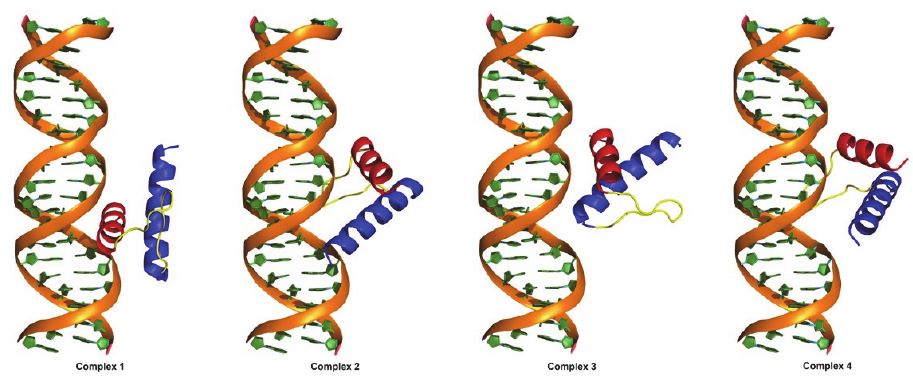
Figure 2. Starting configurations used in the wt:p10 MD simulations in complex with dsDNA.